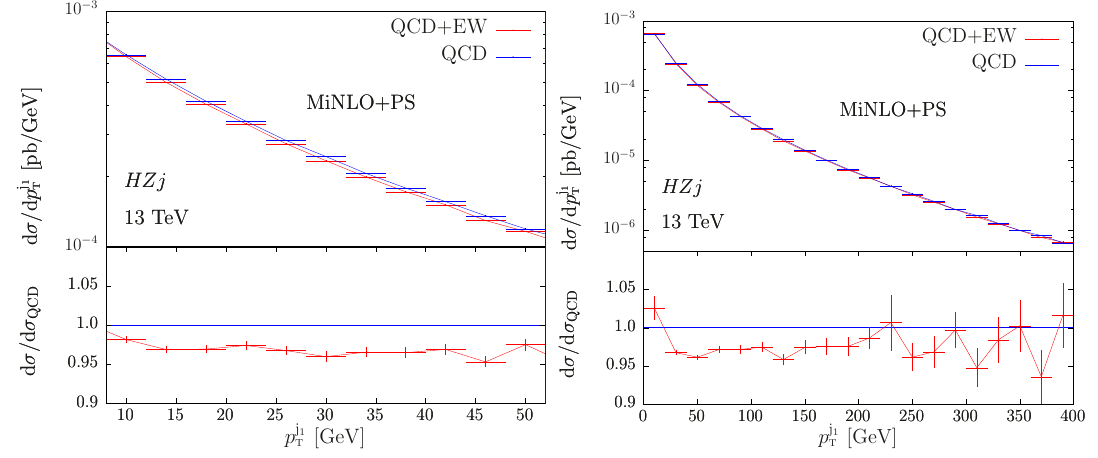
Figure 24. MiNLO +PS predictions for the transverse momentum of the leading jet in two transverse-momentum ranges in HZj production. Same curves and labels as in (cid:12)gure